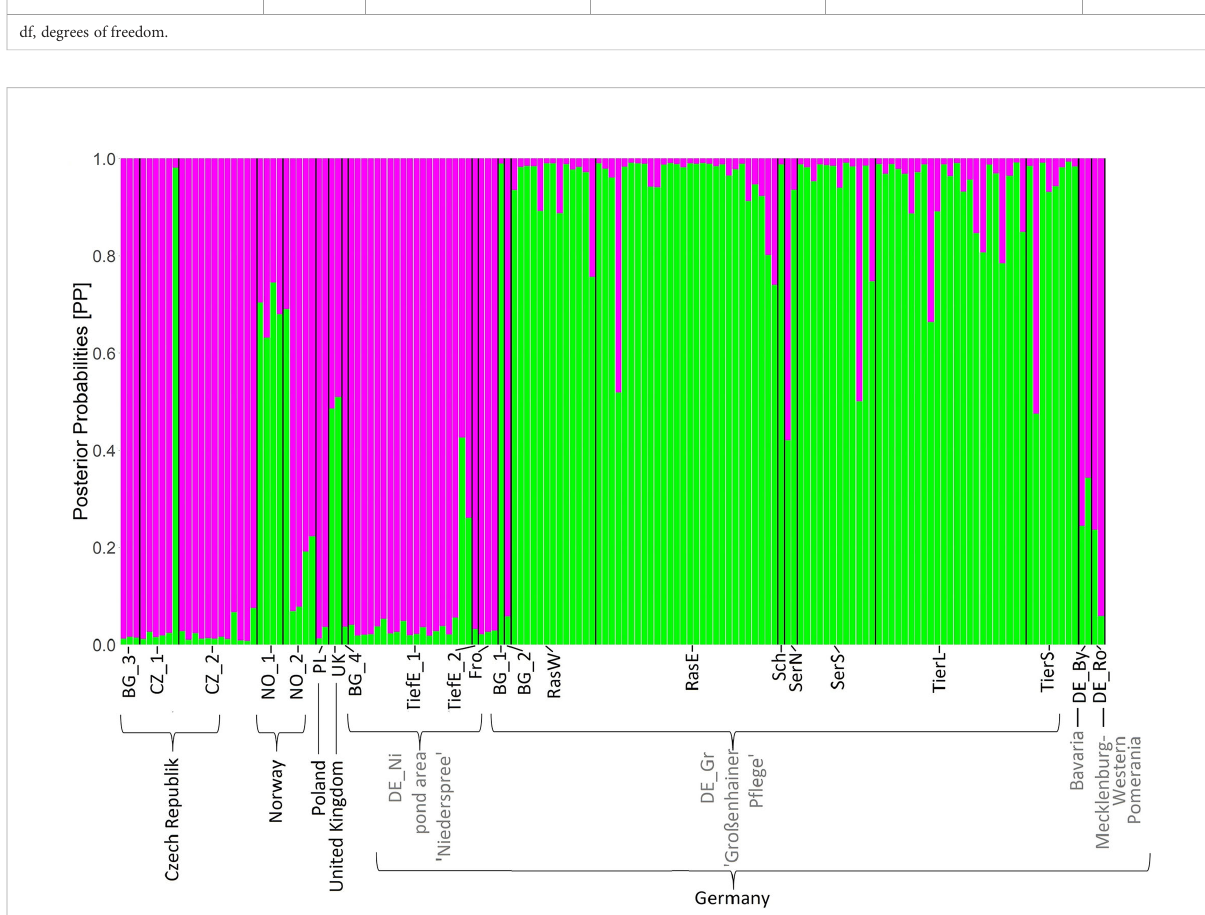
FIGURE 3 Bayesian clustering based on 48 loci AFLP for the model K = 2. Length of the colored bars indicates posterior probabilities (PP) for belonging to one of the two clusters (pink and green). Abbreviations for populations are according to Table